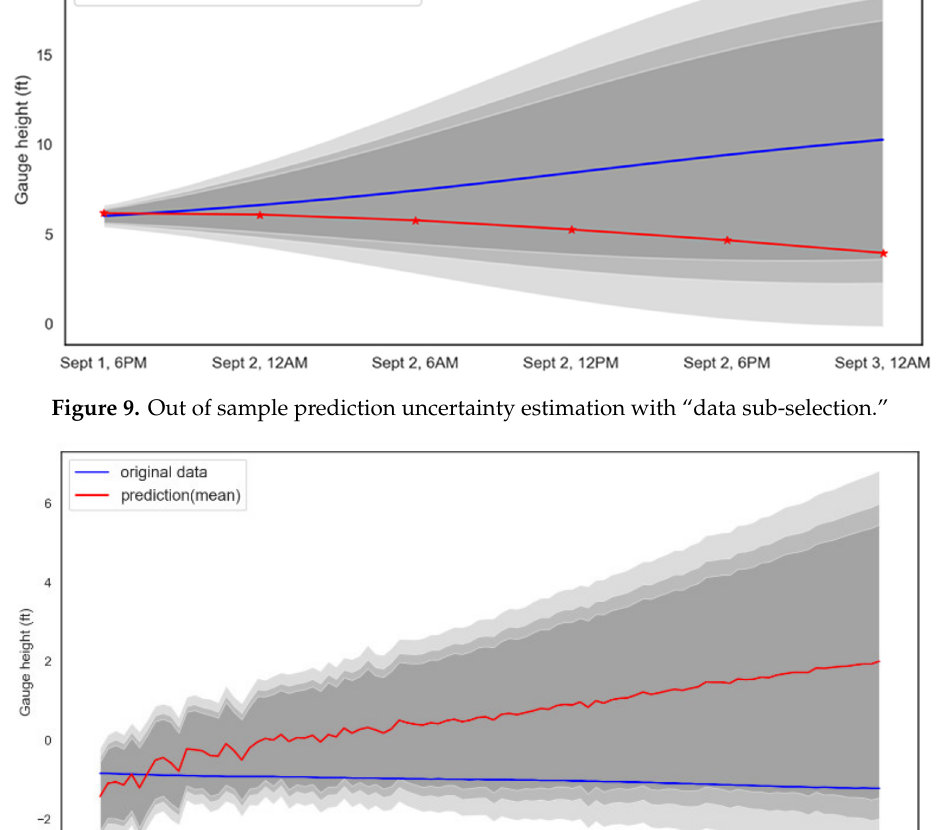
Figure 11. Forecasts of river level with uncertainty with increasing gauge. The mean prediction for a day ahead into the future shows a deviation of approximately 2 ft. and a 95% confidence interval range of 8 ft for scenario 1. Further, the model was used to generate the forecasts when the gauge height is increasing and the corresponding results can be seen in Figure 11. The predicted mean during validation shows little deviation from the actual data, showing the capability of the model for real time gauge height predictions. The lead-time from the above figure can be observed to be 1 day and 1 hour. The model gives the flexibility to adjust the lead-time. Therefore, it provides the ability to modify according to the corresponding user’s requirements. 4. Discussion Deep learning models are based on the assumption that the layers and activation function would be able to capture the seasonality and trend within the data. Gauge height prediction is a complex problem as it is an observation from an intricate system consisting of weather and geophysical elements. Obtaining all the information is data intensive and in most situations, the data is not